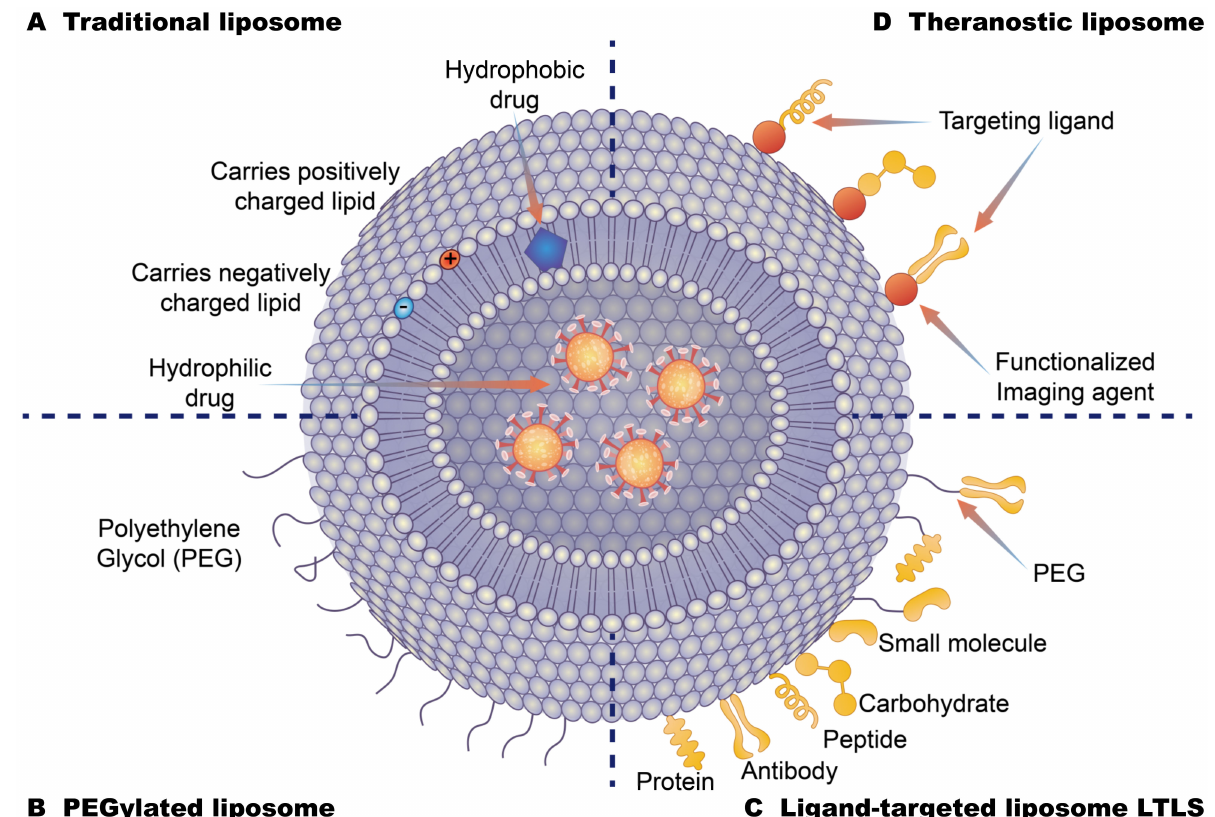
Figure 5. Different types of liposome drug-loading strategies ( A ): Traditional liposomes are based on the phospholipid bilayer. Hydrophobic drugs are loaded into the middle of the bilayer, and hydrophilic drugs are loaded on the internal surface of liposomes with positive and negative potential lipid molecules. ( B ): Polyethylene glycol liposomes are covered by polyethylene glycol on the surface of the liposome. These cover the hydrophobic layer of the liposome to extend the circulation time of the liposome in the body. ( C ): Ligand-targeting liposomes are bound to the surface of liposomes by specific targeting molecules to enhance the targeting of liposomes. ( D ): Therapeutic liposomes are composed of nanoparticles, target units, contrast agent components, and therapeutic agent